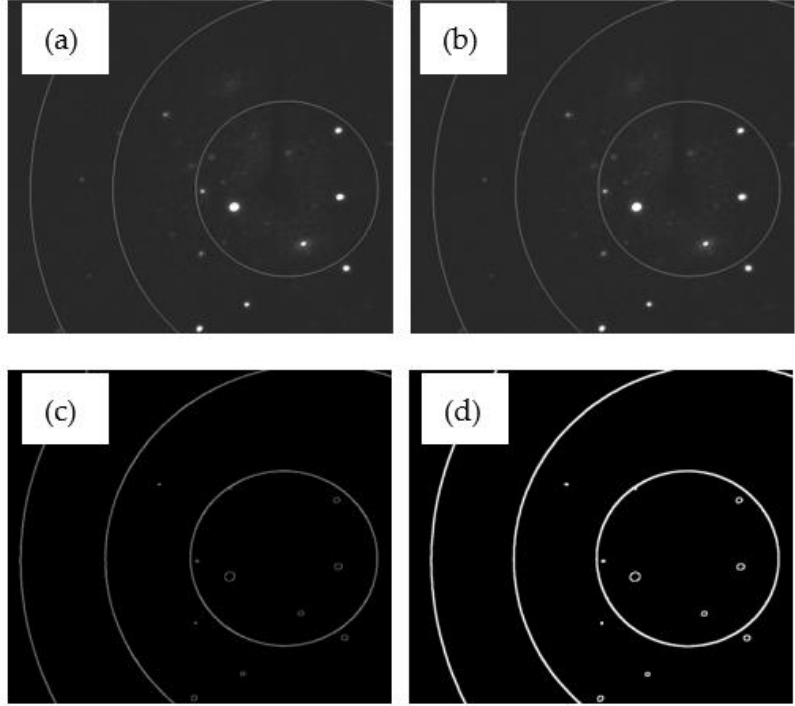
Figure 5. Preprocessing a colorful image consequentially by ( a ) conversion to grayscale image, ( b ) Gaussian filtering treatment, ( c ) canny edge detection, and ( d ) edge dilated treatment.